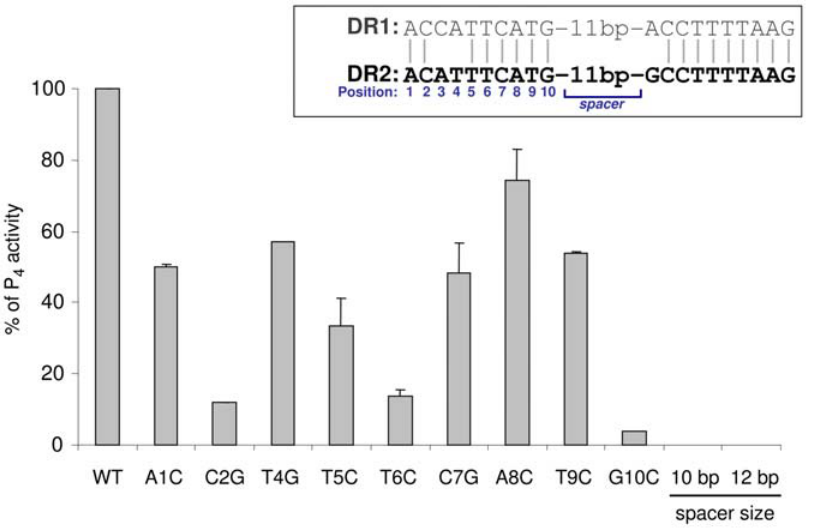
Figure 3. The relative contribution of the different positions in DR2 to the transcriptional strength of P 4 promoter. The location of the positions and the invariant bases of DR1 and DR2 are shown in the inset. Substitutions of the indicated nucleotides with cytosine or guanine, and increase or decrease of the spacer size by a single nucleotide, were achieved by site-directed mutageneses that were performed on the p P 4 -gfp plasmid (see ‘‘Materials and Methods’’). JS95 was transformed with p P 4 -gfp or with the resulting mutated plasmids. The corresponding strains were grown to an OD 600 =0.2, then SilCR was added to a final concentration of 10 m g ml 2 1 and the cultures were further incubated for 1 h. Fluorescence intensities were determined at time 0 and then every 15 min, as described in ‘‘Materials and Methods’’. The slopes of fluorescence intensity as a function of time (representing initial rates of GFP accumulation) were calculated by performing least square analyses, which yielded coefficients of determination greater than 0.95 (R 2 . 0.95). The P 4 activity of JS95 transformed with non-mutated p P 4 -gfp (WT) was designated 100%, and the activities of the other mutants were calculated accordingly. The P 4 activity in the absence of SilCR was negligible (not shown). The values shown are the mean 6 the standard deviation results of at least two independent